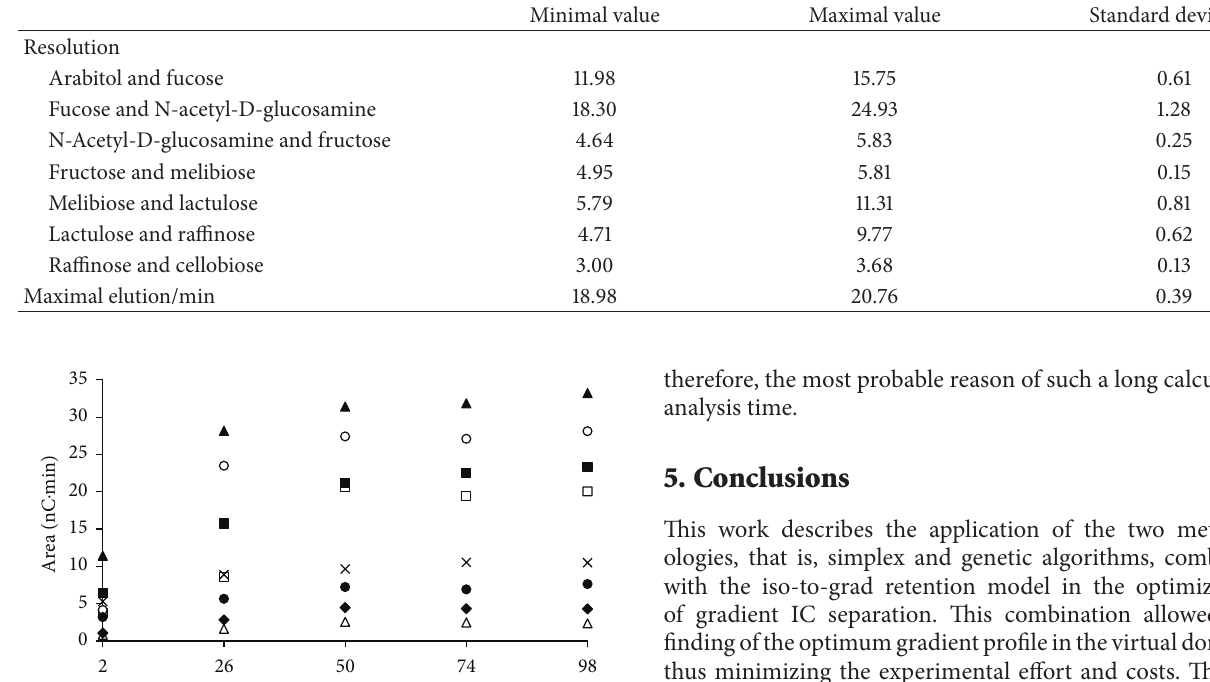
Table 2: Comparison of the calculated resolutions of 220 calculations using genetic algorithm.